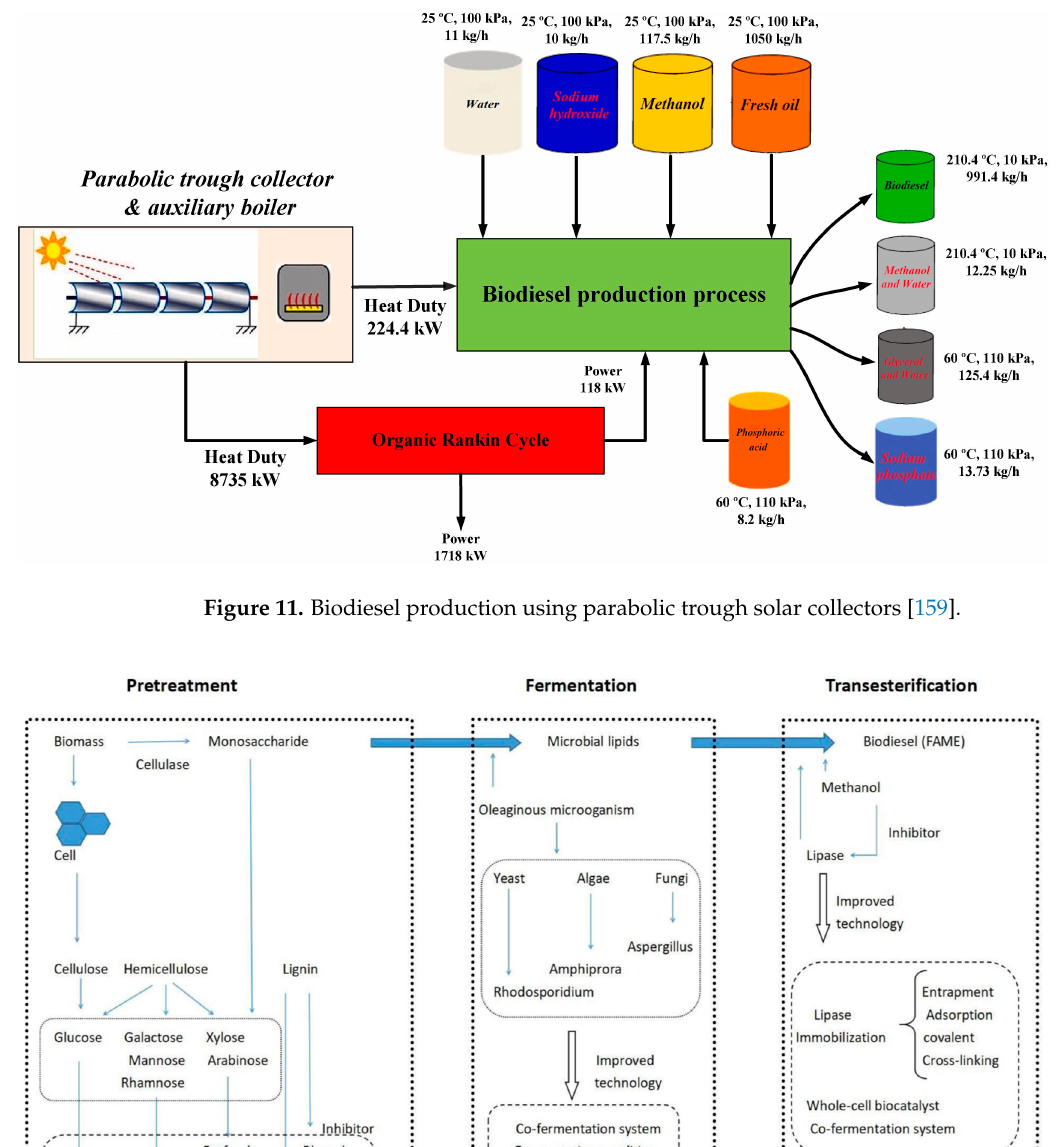
Table 7. Benefits and Limitations of different generations of biodiesel [163,164].